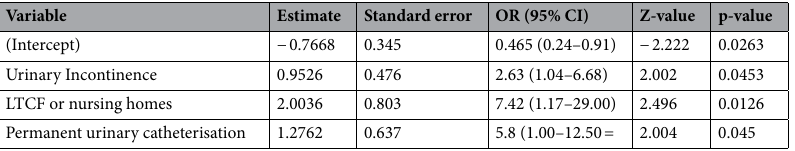
Table 6. Logistic regression model of risk factors for UTI caused by MDR organisms.